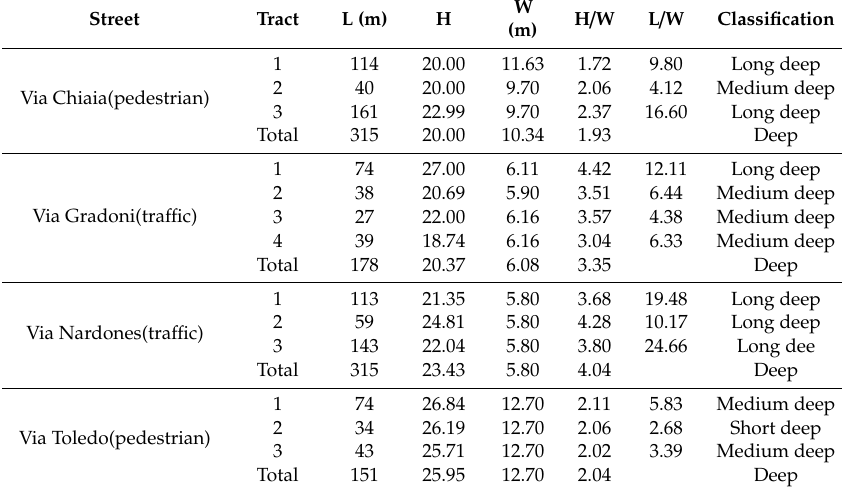
Table 1. Main geometric parameters of the four monitored